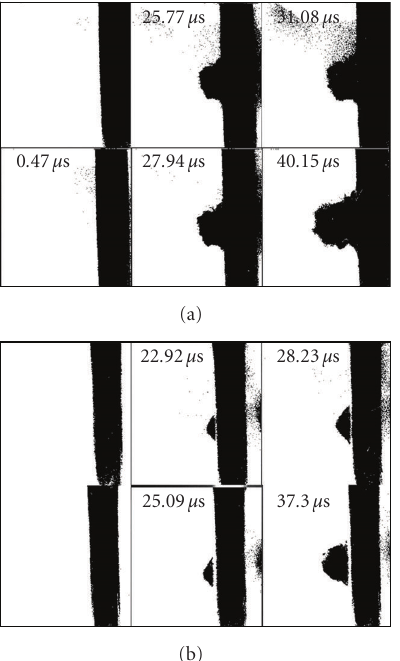
Figure 7: High speed photograph (a) neat sandwich (b) nano- phased sandwich.